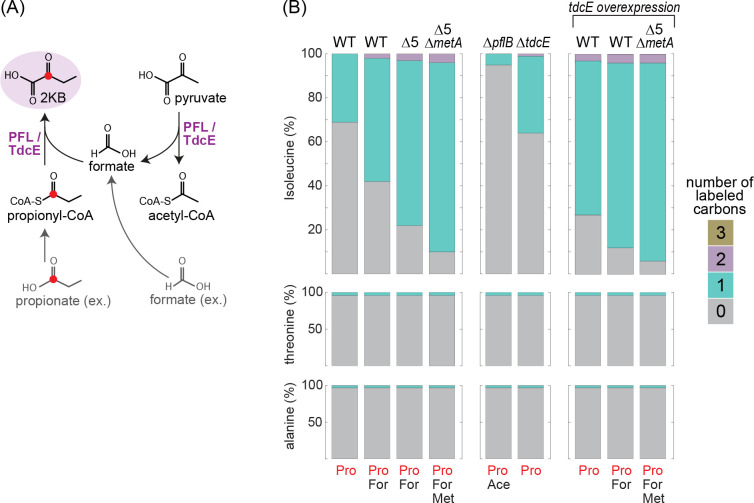
13C-labeling of isoleucine reveals the activity of the KBFL route under anaerobic conditions.(A) Schematic representation of 2-ketobutyrate production via PFL/TdcE-catalyzed reaction. Compounds in gray are added to the medium (external) while those in black represent intracellular metabolites. The red circle indicates the labeled carbon. (B) 5 mM of propionate-1-13C were added to the medium of different strains cultivated on 10 mM glucose. 10 mM acetate, 30 mM formate, and/or 2 mM methionine were added to the media of some strains, as indicated at the bottom of the figure. Alanine and threonine were not labeled in all cases, confirming that the labeling of isoleucine is derived from direct propionate conversion to 2 KB.Figure 9—source data 1.Retention time, relative peak, and m/z for the carbon labeling experiment.